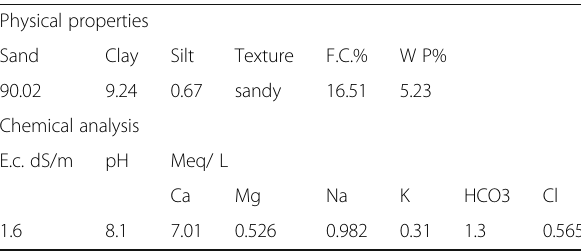
Table 1 Physical properties and chemical analysis of the experimental soil Physical properties